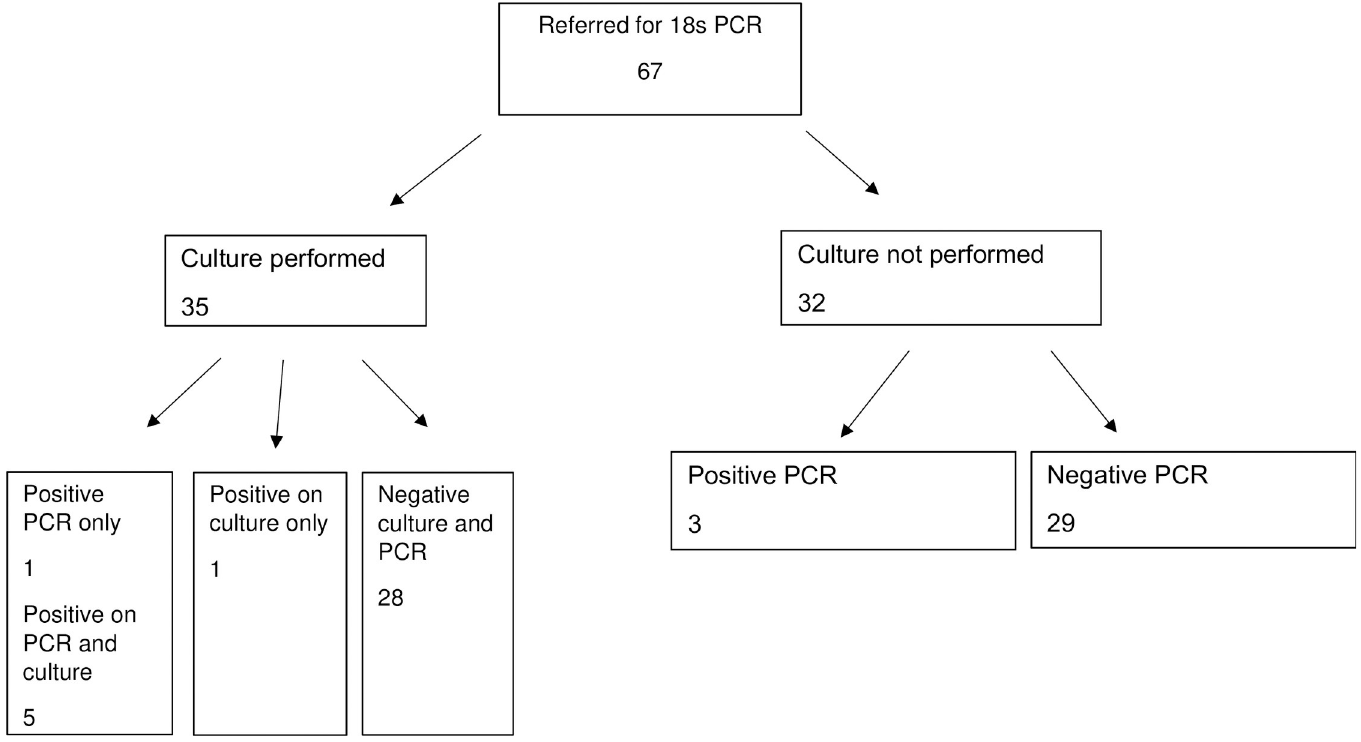
Fig 2. Results for samples referred for 18s PCR versus